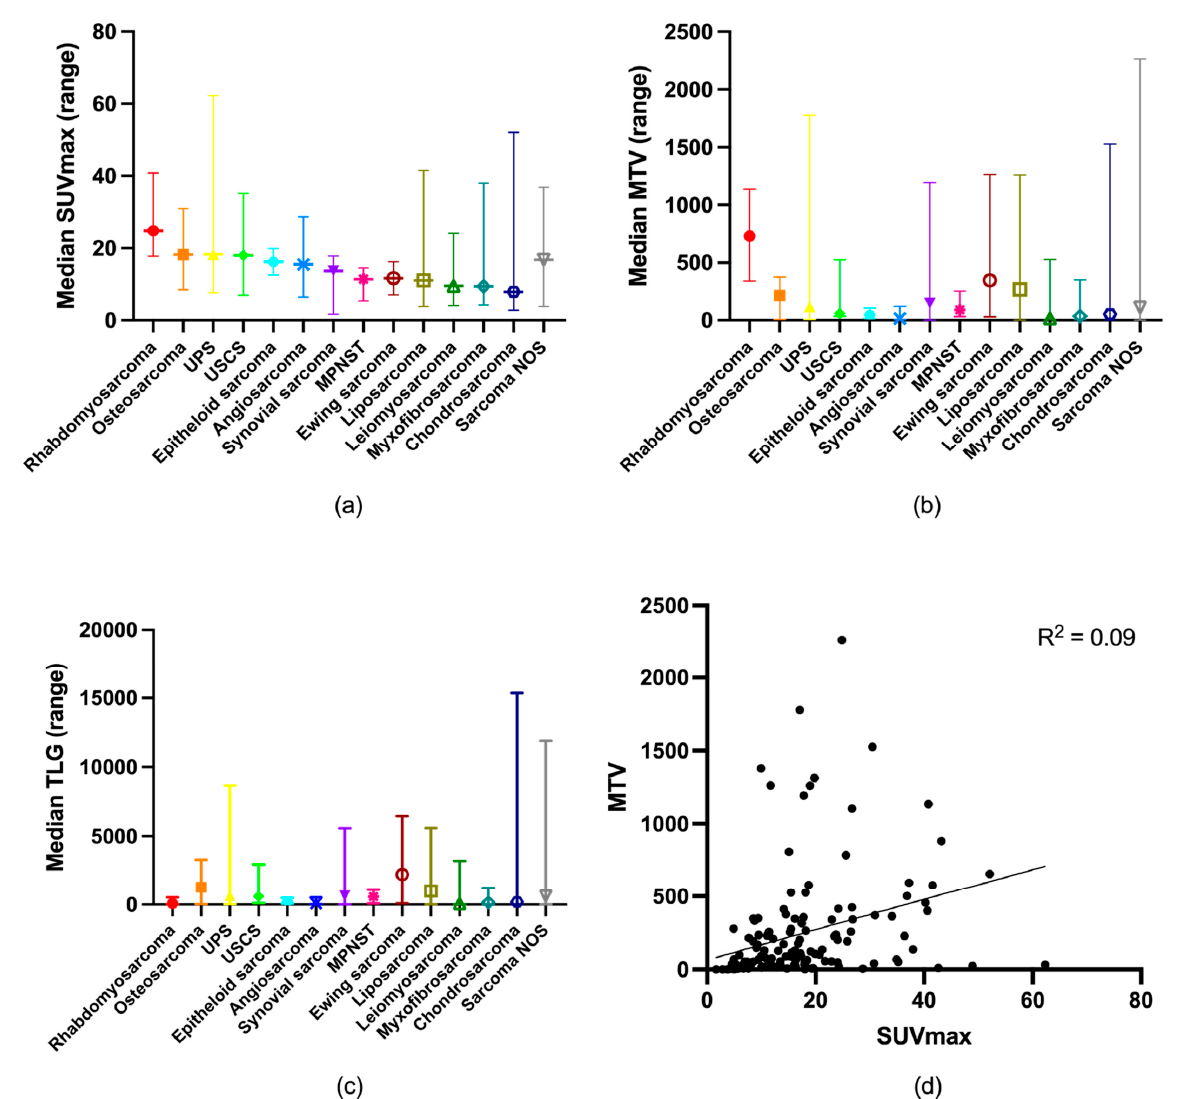
Figure 2. Distribution of ( a ) SUVmax; ( b ) MTV2.5; and ( c ) TLG2.5 according to sarcoma type. ( d ) Correlation between SUVmax and MTV2.5.